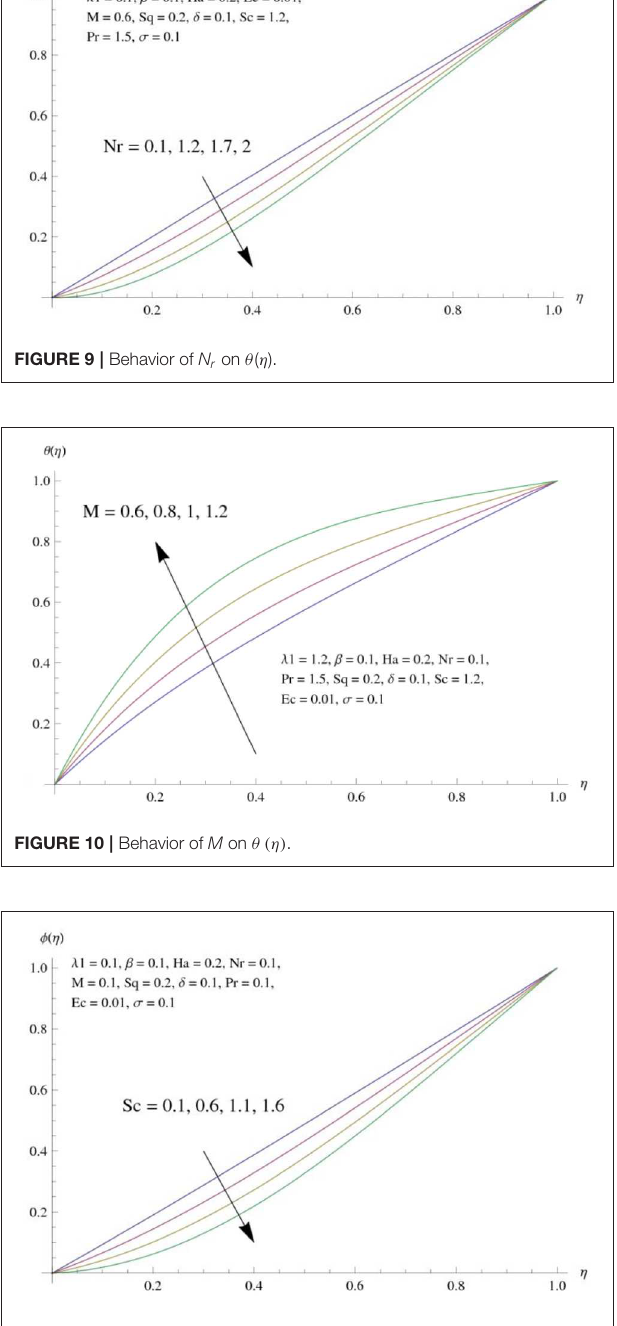
FIGURE 11 | Behavior of Sc on φ ( η